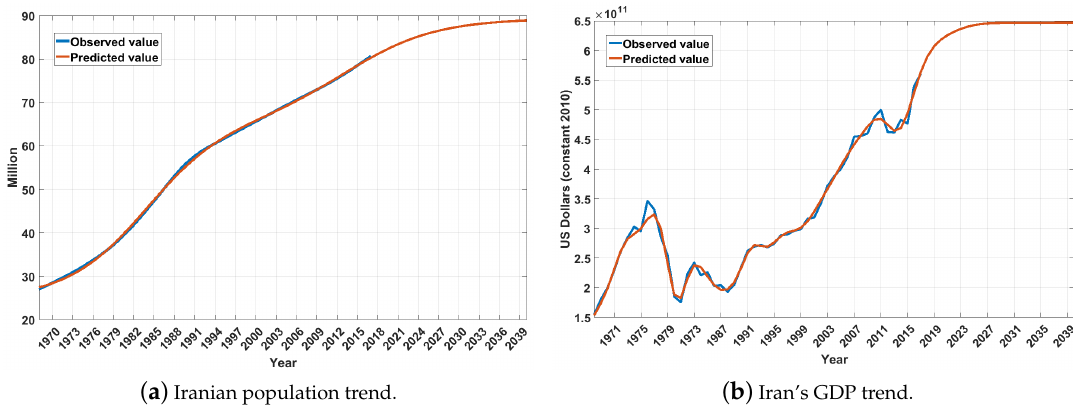
Figure 4. Population and GDP trends in